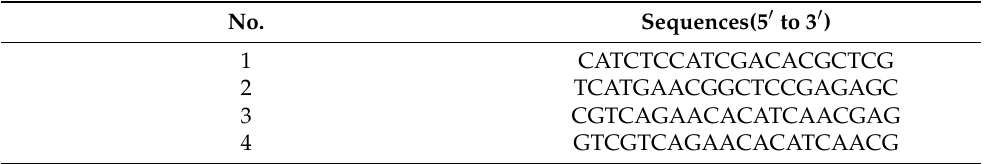
Table 2. Design single-stranded DNA oligonucleotides. No. Sequences(5 (cid:48) to 3 (cid:48)